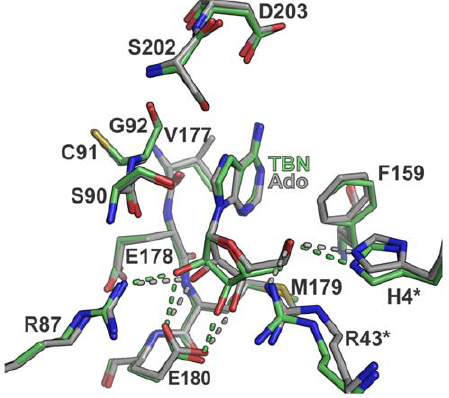
Figure 6. The binding mode of tubercidin. Structural comparison between the BsPNP233-TBN (carbon atoms in green ) and BsPNP233- Ado (carbon atoms in grey ) complexes. Dashed lines indicate hydrogen bonds and are colored according to their respective